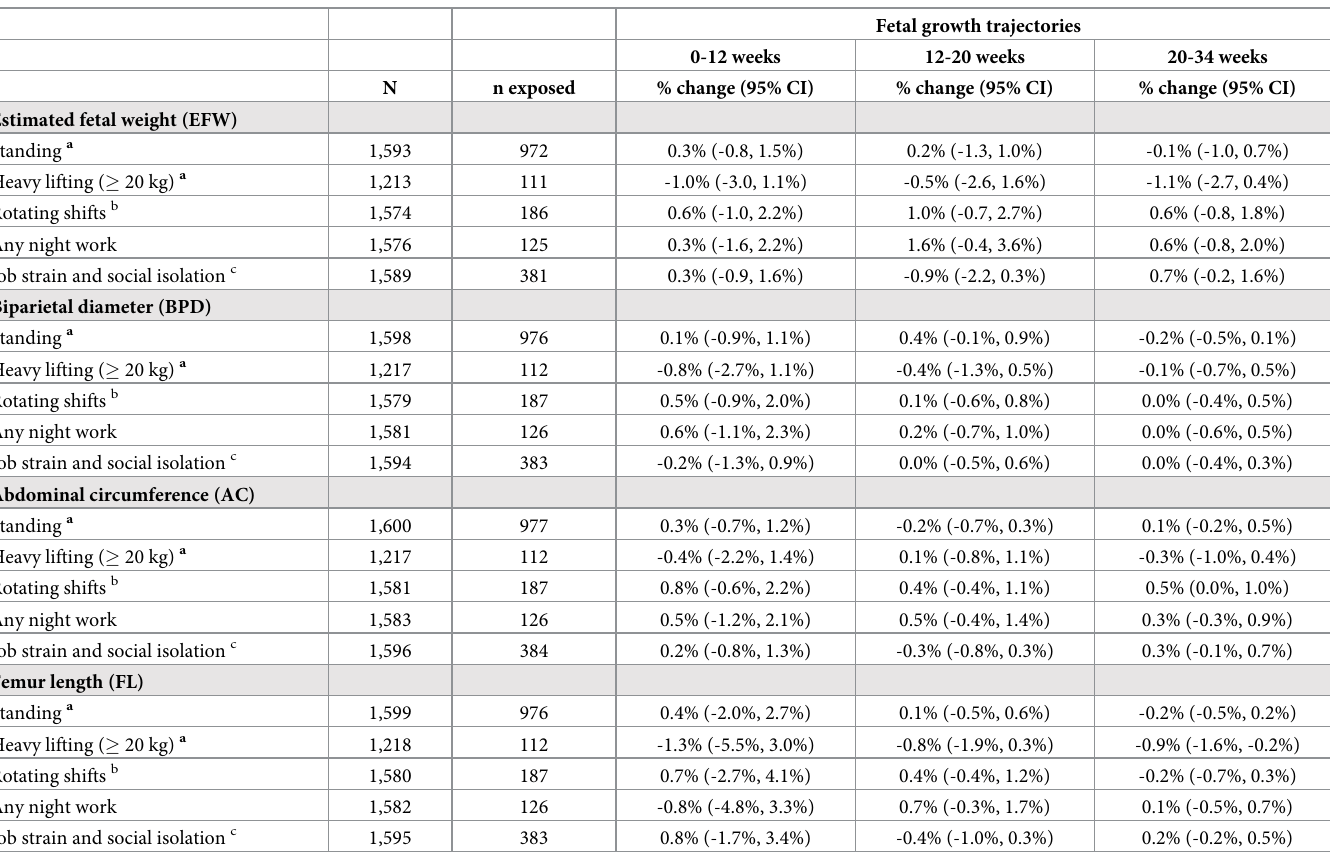
Table 3. Associations between self-reported exposure to non-chemical occupational factors and growth trajectories in estimated fetal weight, INMA,